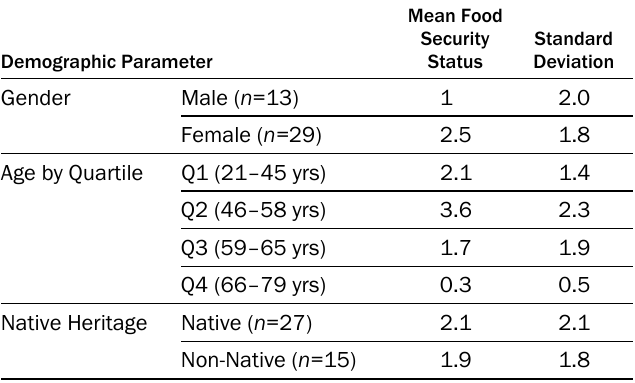
Table 1. Mean Food Security Score by Gender, Age, and Native